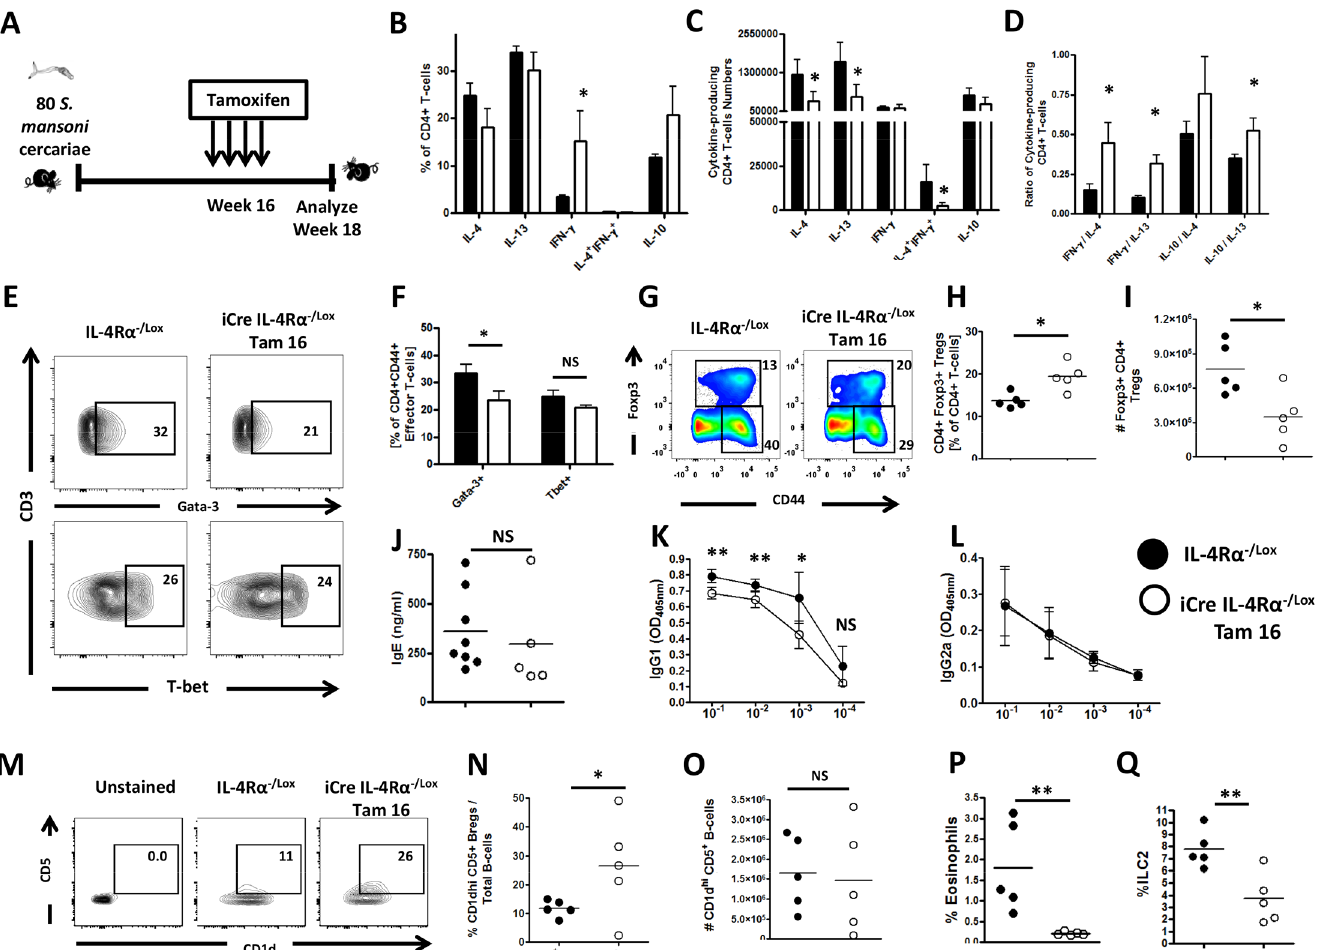
Fig 7. Immunological polarization of S . mansoni- infected mice after knocking down IL-4R α 16 weeks post-infection. A. Experimental designfor Immunologicalassays. Percentages( B ), numbers( C ) and ratios ( D ) of cytokine-producingCD4 + T cells after stimulationwith PMA/Ionomycin/Monensin cocktail. E. Percentagesof various transcription factor-expressing CD4 + T cells ( ex-vivo )summarized in F. G. Representative plot of MLN Foxp3 + CD4 + regulatory T cells (gated on CD3 + CD4 + Lymphocytes). Summaries of frequencies( H ) and total cell numbers ( I ) of MLN Foxp3 + Tregs. J. Total seric IgE in S . mansoni-infected mice. SEA-specificseric IgG1 ( K ) and IgG2a ( L ) isotype antibodies. M. Representative plot of MLN CD1d hi CD5 + regulatoryB cells (gated on CD19 + Lymphocytes). Summaries of frequencies ( N ) and total cell numbers( O ) of CD1d hi CD5 + regulatoryB cells (gated on CD19 + Lymphocytes) per MLN. P. Frequenciesof SSC hi SiglecF + eosinophilswithin total MLN cells. Q. Frequencies of MLN Lin - T1/ST2 + ICOS + (ILC2) cells. Each experiment was conductedat least twice with 5–10 mice per group. Data are expressedas mean ± SD; NS = p > 0.05; * = p < 0.05; ** = p < 0.01; *** =, p < 0.001; **** = p < 0.0001.